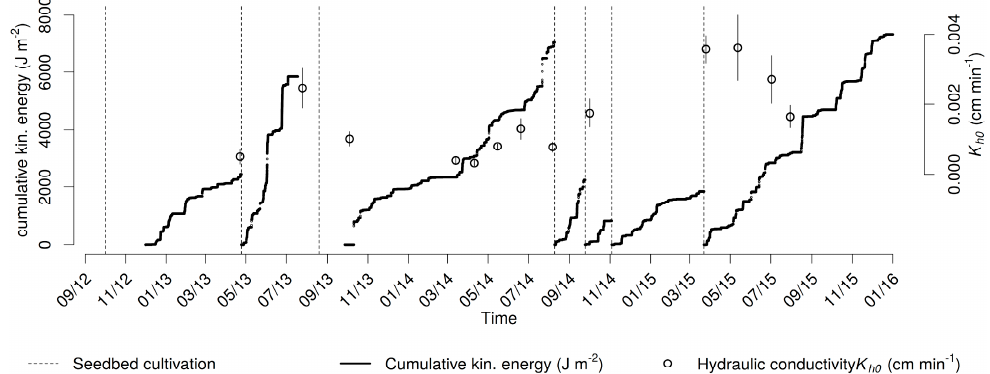
Figure 10. Seasonal variability of the scaled unsaturated hydraulic conductivity related to cumulative rainfall kinetic energy. Seedbed cultivation (dashed line) is assumed to interrupt the effect of the previous rainfall.